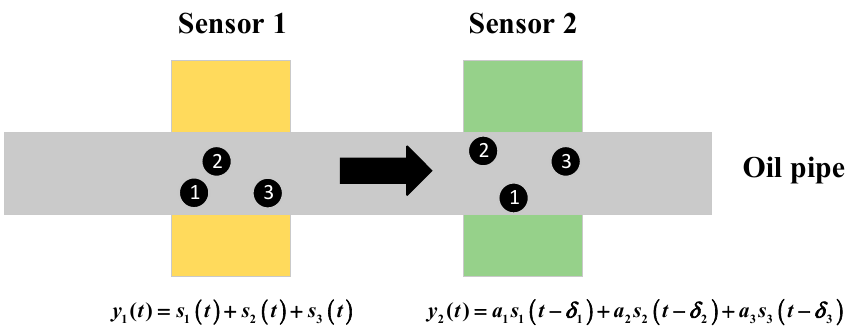
Figure 2. Detection layout based on two radial magnetic field (RMF) sensors.